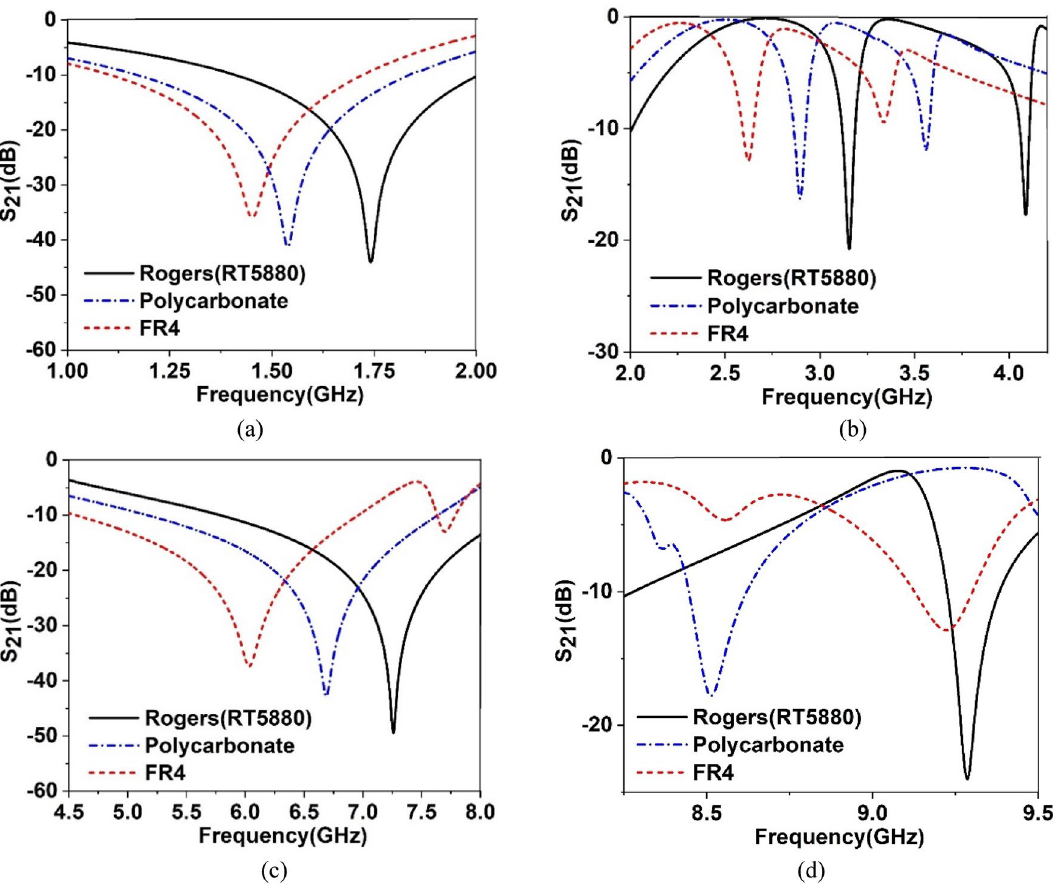
Figure 8. S 21 response of the proposed MTM with Rogers(RT5880), Polycarbonate and FR4 dielecrtic layer over resonator within: ( a ) 1–2 GHz, ( b ) 2–4 GHz, ( c ) 4.5–8 GHz, ( d ) 8.2–9.5 GHz.